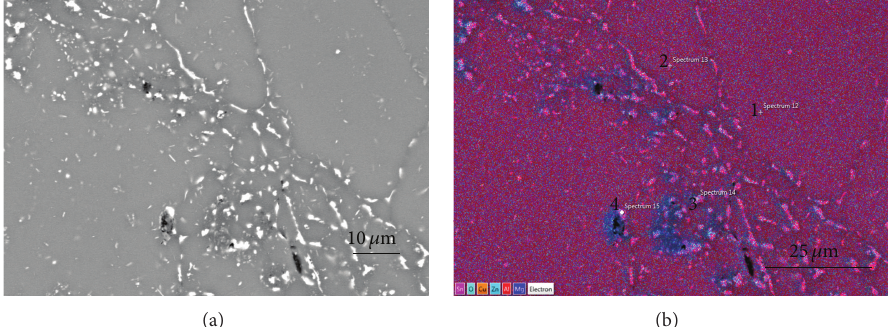
Figure 4: (a) SEM image of sintered Alumix 431D and (b) selected area and location for mapping and point elemental analysis of sintered Alumix 431D by EDS numbered from 1 to 4.